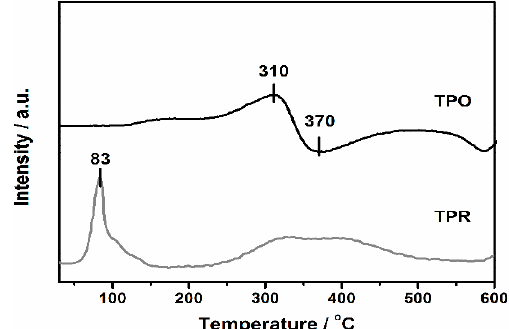
Figure 4. Temperature programmed oxidation (TPO) pattern of the pristine Pt / TiO 2 catalyst and temperature programmed oxidation (TPR) pattern of the unreduced Pt / TiO 2 catalyst.